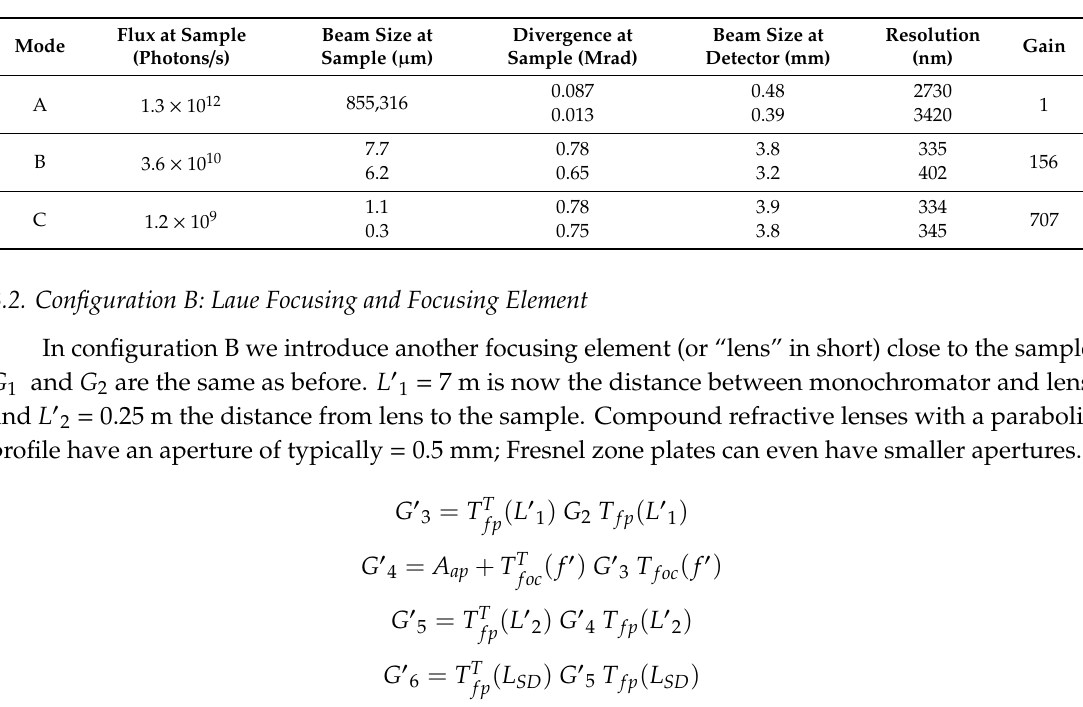
Table 2. Flux, beam size and divergence (as standard deviations), resolution, and gain for modes A, B, and C. For beam size, divergence, and resolution the top and bottom numbers correspond to the horizontal and vertical dimensions,